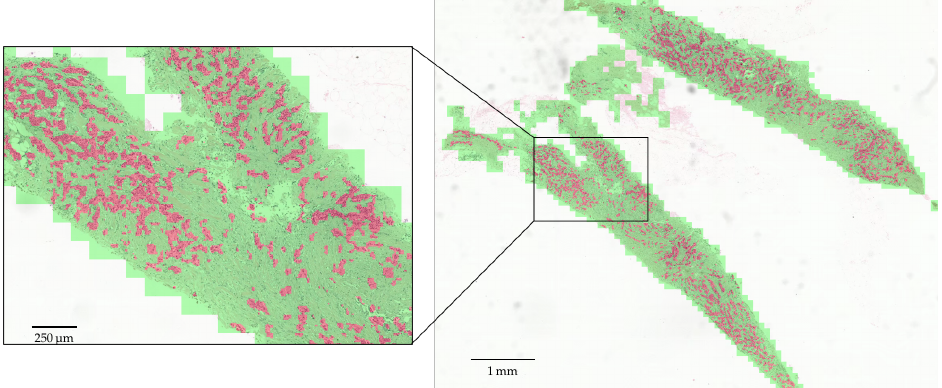
Figure 7. Segmentation results on a whole slide